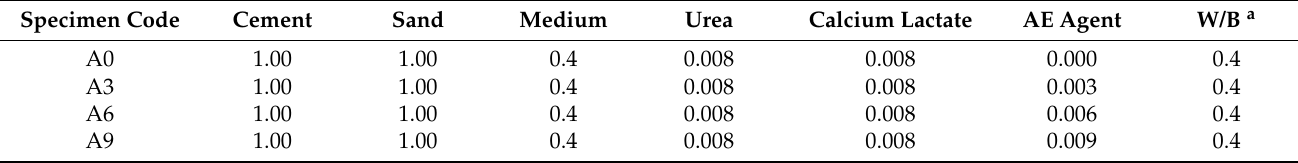
Table 2. Mix proportion of mortar specimens by mass